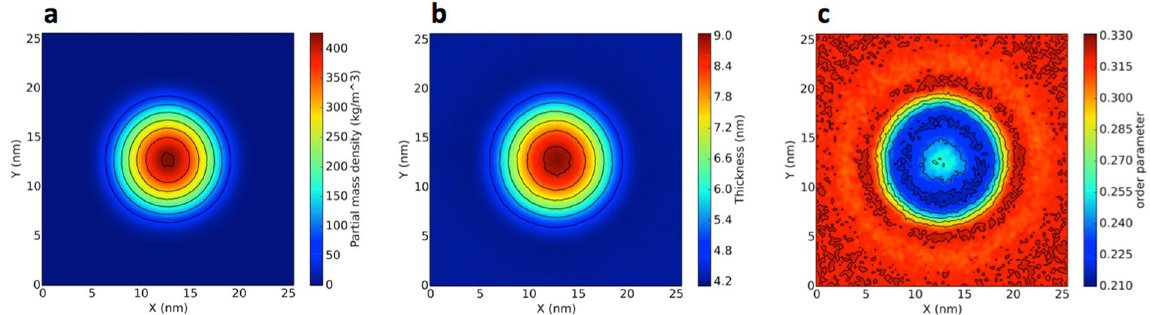
Figure 3. Two dimensional maps of ( a ). PE density, ( b ). Membrane thickness and ( c ). Lipid chains order parameter. The maps refer to PE80 in a pure POPC membrane. The center of mass of PE was translated to the center of the